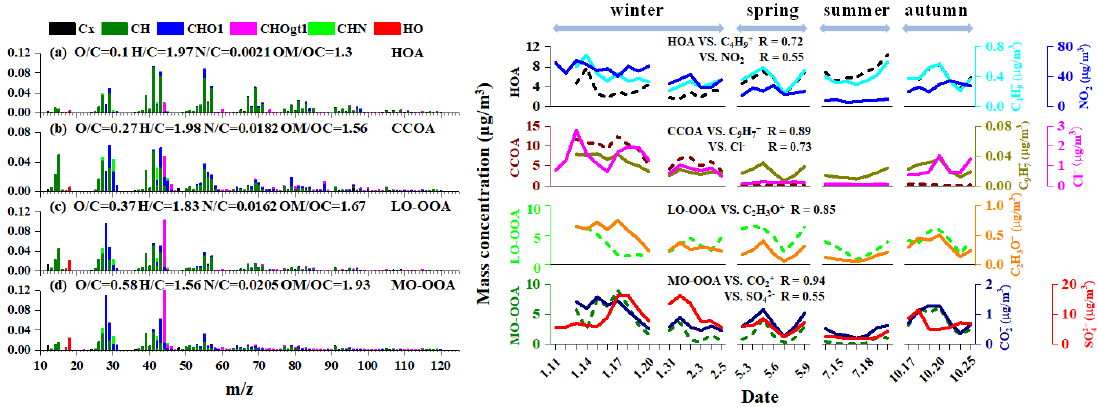
Figure 6. The mass spectra of HOA, CCOA, LO-OOA, and MO-OOA, as resolved by PMF. The time series of the four factors and the corresponding tracer ions are shown in the right panel. The correlation coefficients (R) between OA factors and tracers are also shown.